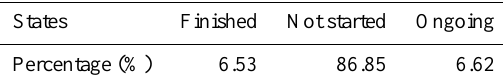
Table 3. The percentages of each state of reconstruction.